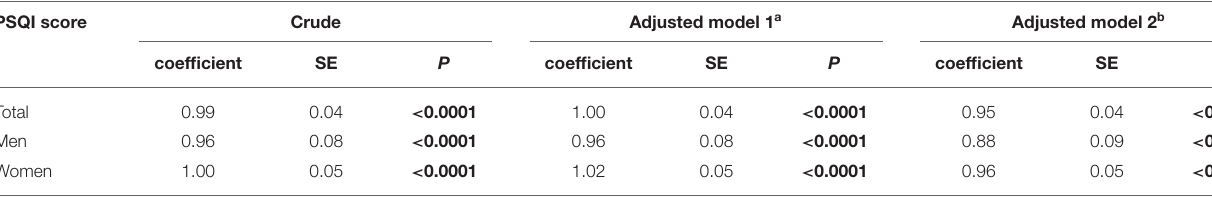
TABLE 2 | The linear associations between PSQI score and PHQ-9 score * . PSQI score Crude